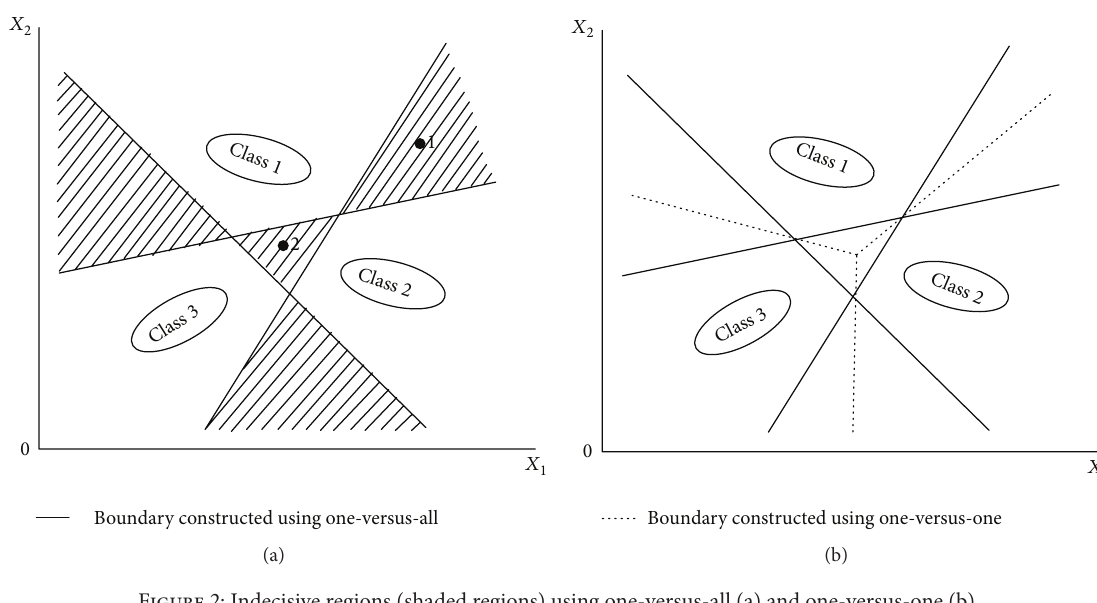
Figure 2: Indecisive regions (shaded regions) using one-versus-all (a) and one-versus-one (b).